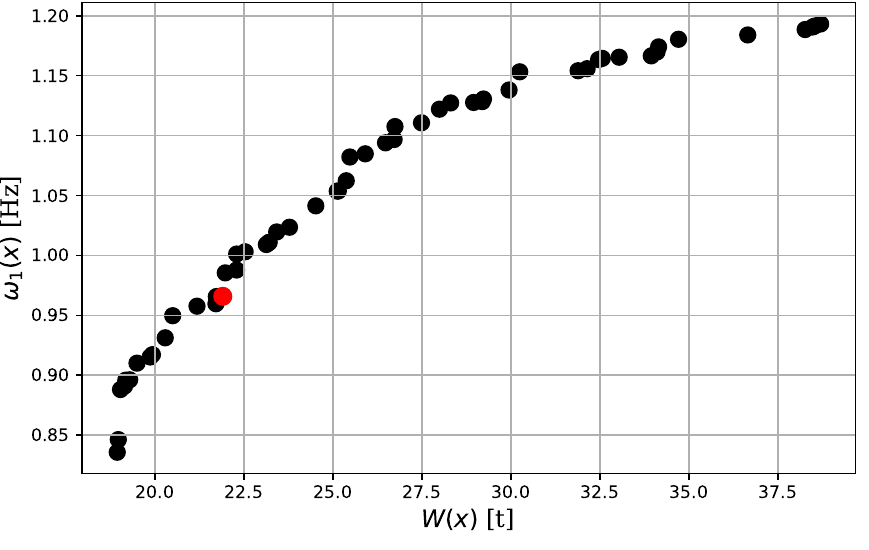
Figure 9. PF obtained for